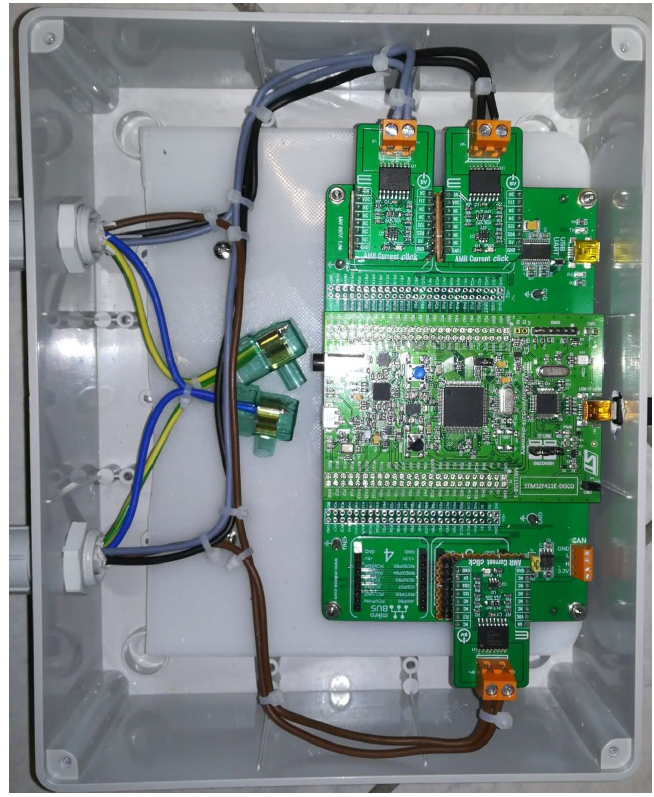
Figure 8. Data acquisition